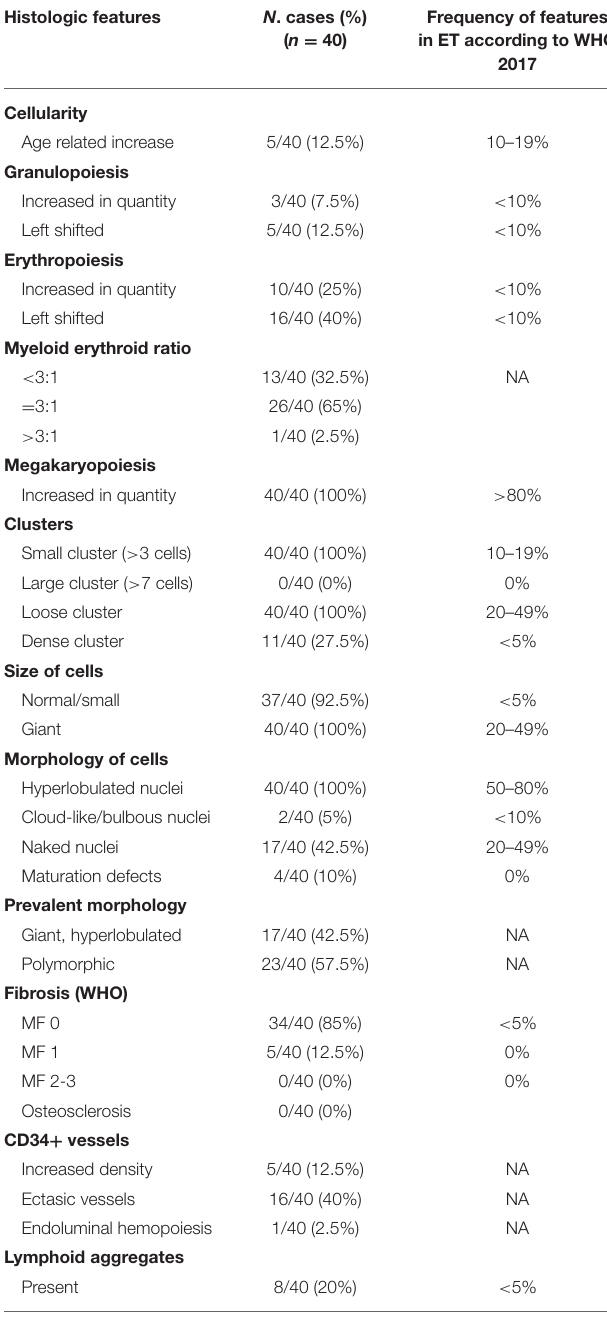
TABLE 2 | Histologic features of 40 triple-negative ET patients. Histologic